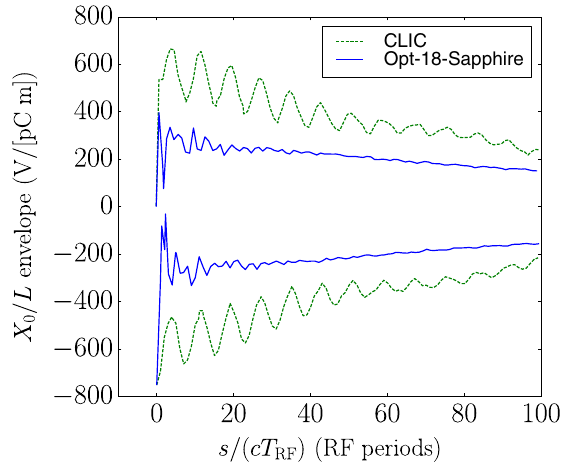
FIG. 12. The monopole wake potential envelope is smoother for the Opt-18-Sapphire cavity. However, the amplitude of the accelerating mode is lower, indicating weaker coupling to the beam (see Appendix